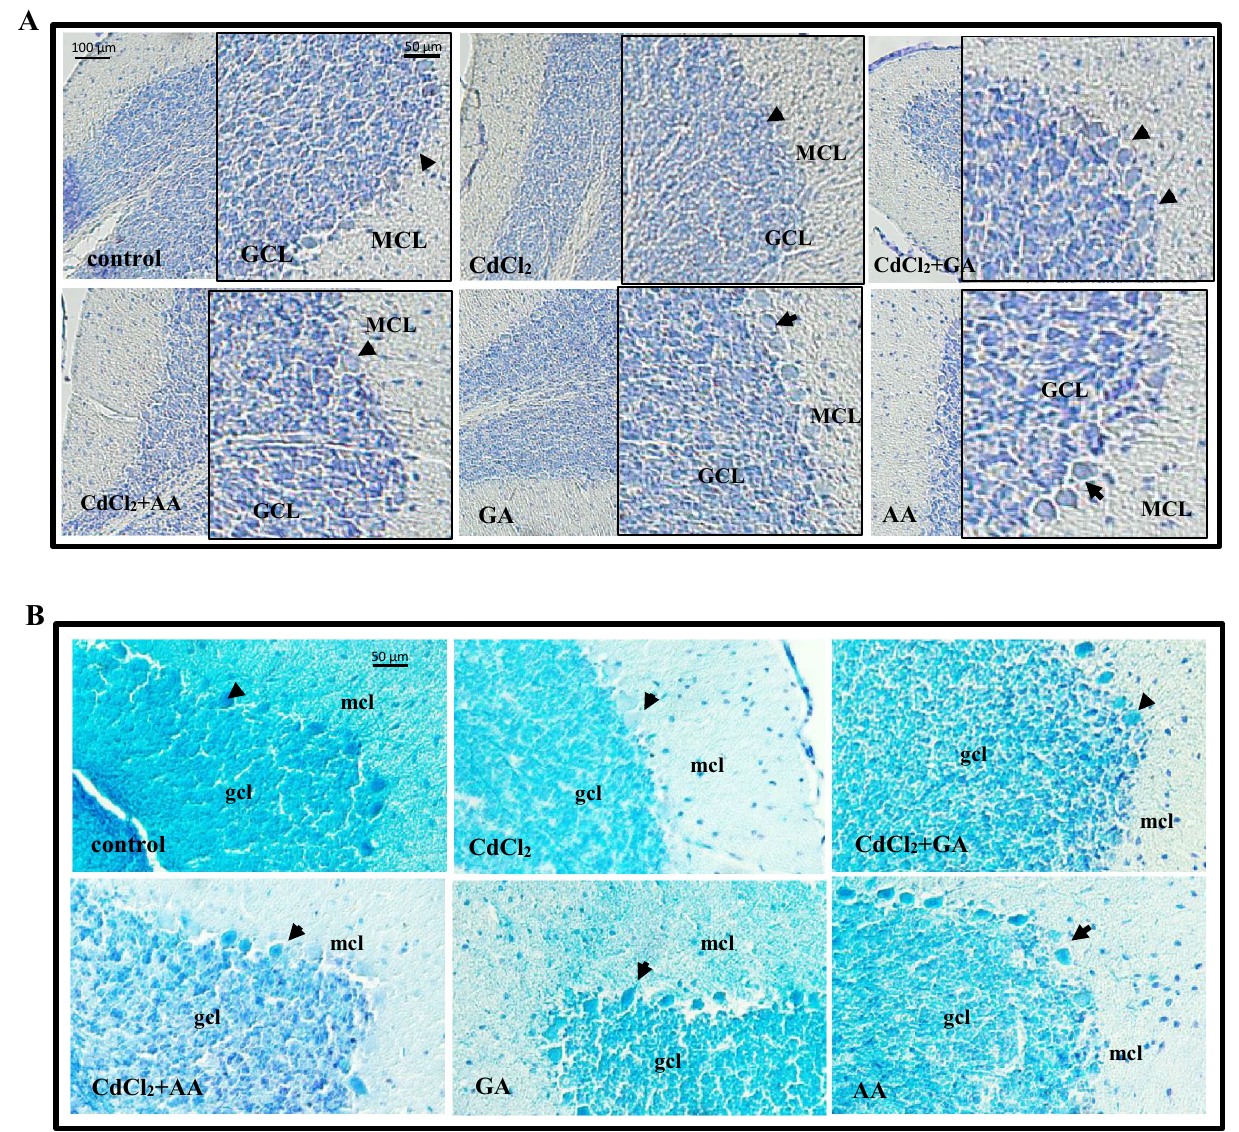
Figure 11. The cerebellum of experimental rats showing the molecular, Purkinje and granule cell layers with ( A ) H&E staining and ( B ) Luxol fast blue stain. Control, GA and AA groups had organized molecular cell layer with discrete stellate and basket cells. Large pyriform-shaped cells were also observed in the Purkinje cell layer with small deeply stained granular cell layer. Note the disorganization in the cells of the Purkinje layer in the CdCl 2 group. Molecular cell layer (MCL), Purkinje cell (black arrowheads) and granular cell layers (GCL). GA gallic acid, AA ascorbic